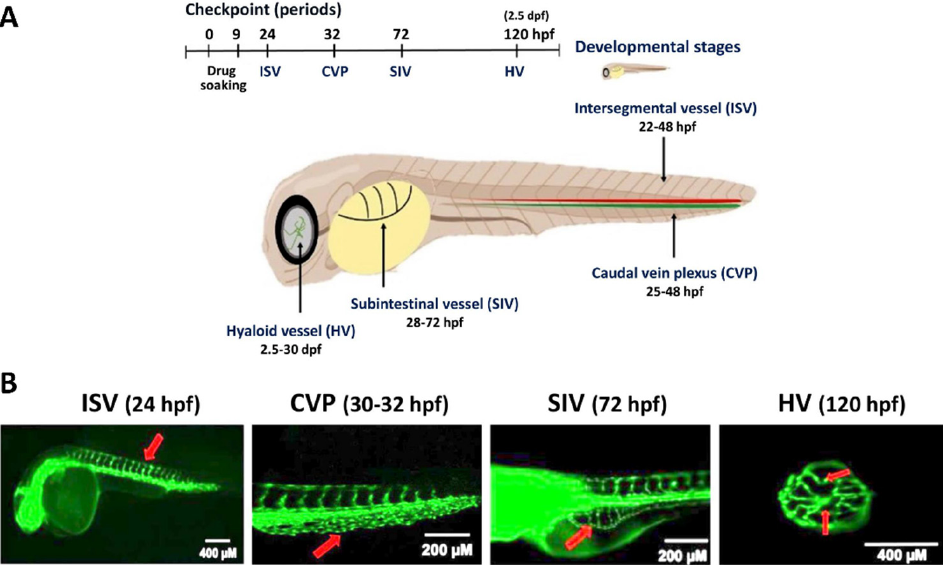
Figure 1. Developmental angiogenesis stages and periods. ( A ) The embryos were subjected to analyses of intersegmental vessel (ISV) formation at 22–48 hpf, caudal vein plexus (CVP) at 25–48 hpf, subintestinal vessel (SIV) at 28–72 hpf, and hyaloid vessel (HV) at 2.5–30 dpf. ( B ) Representative images for different developmental stages. Tg (fli1: EGFP) zebrafish embryos were applied for observing the developmental angiogenesis for different stages. The red arrow indicates these structures.